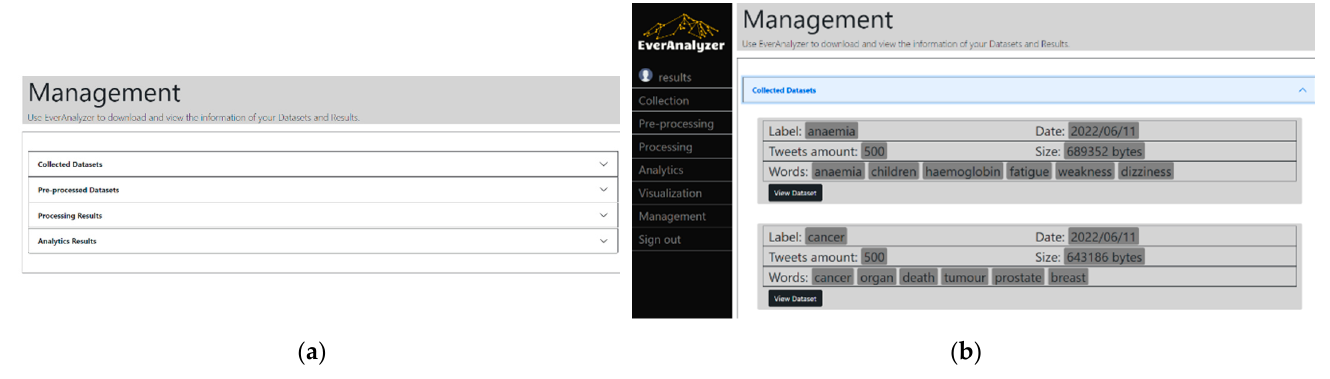
( b ) Figure 22. ( a ) Visualization of processing task; ( b ) Visualization of analysis task. In addition, the management interface allows the user to access all of his/her col- lected, pre-processed, processed, and analyzed datasets and results. It enables the user to view the specified datasets and results as raw data and download all the information from all the completed jobs. An additional functionality is provided for the collected and pre-